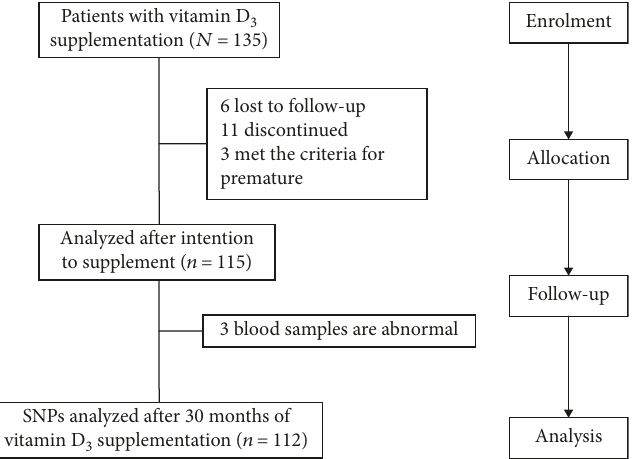
Figure 1: Flow diagram of study selection